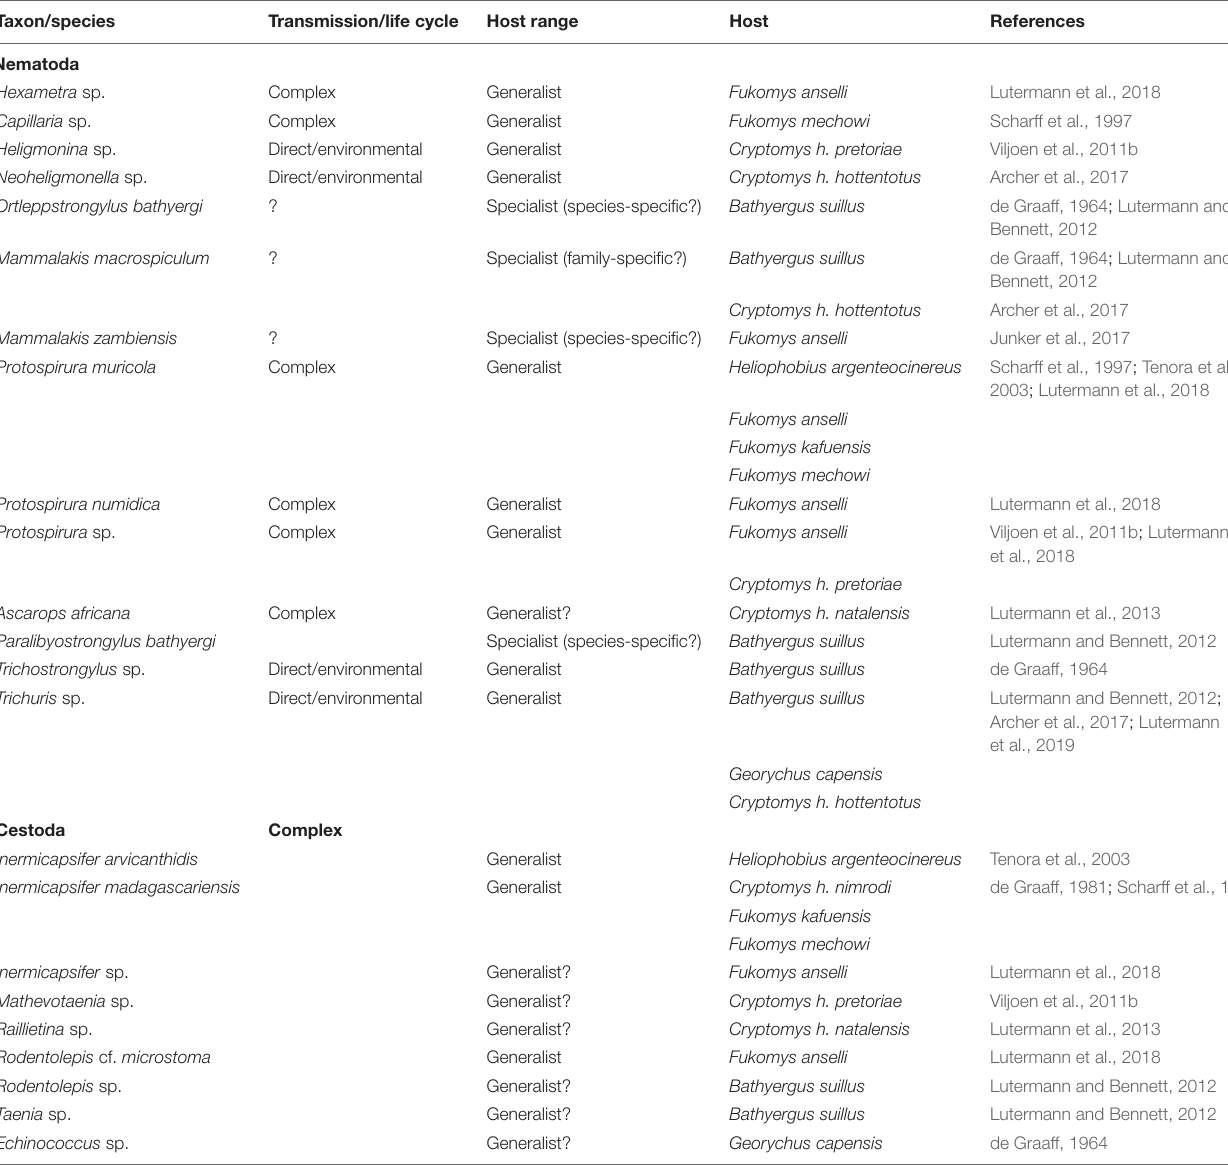
TABLE 3 | Overview of helminth parasite species, their mode of transmission or life-cycle and host range reported for the family Bathyergidae to